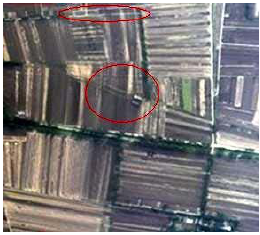
Figure 6. Fusion